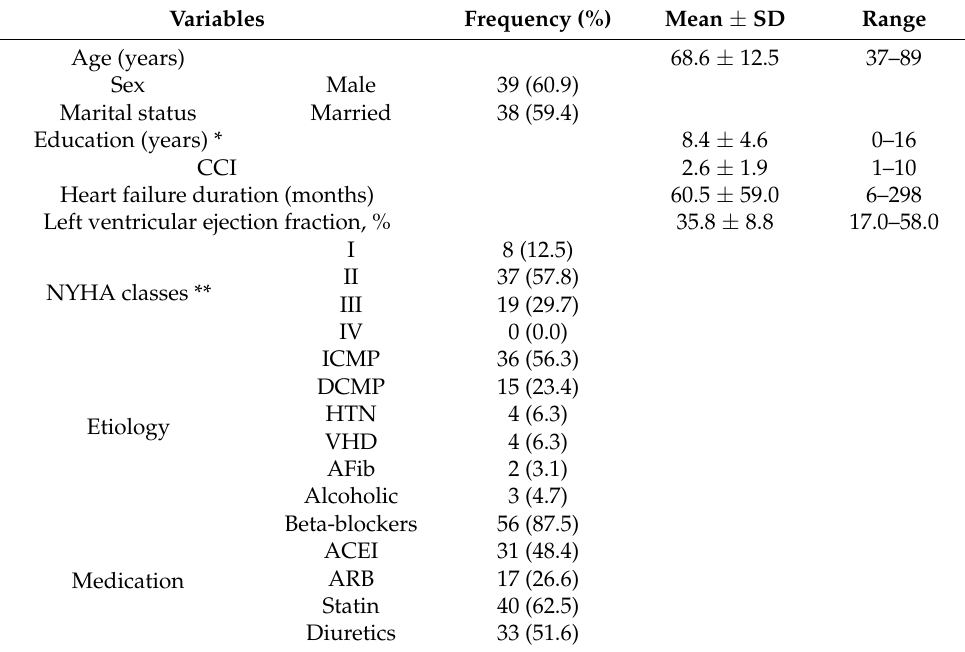
Table 1. Baseline demographic and clinical characteristics of the patients with heart failure ( n =